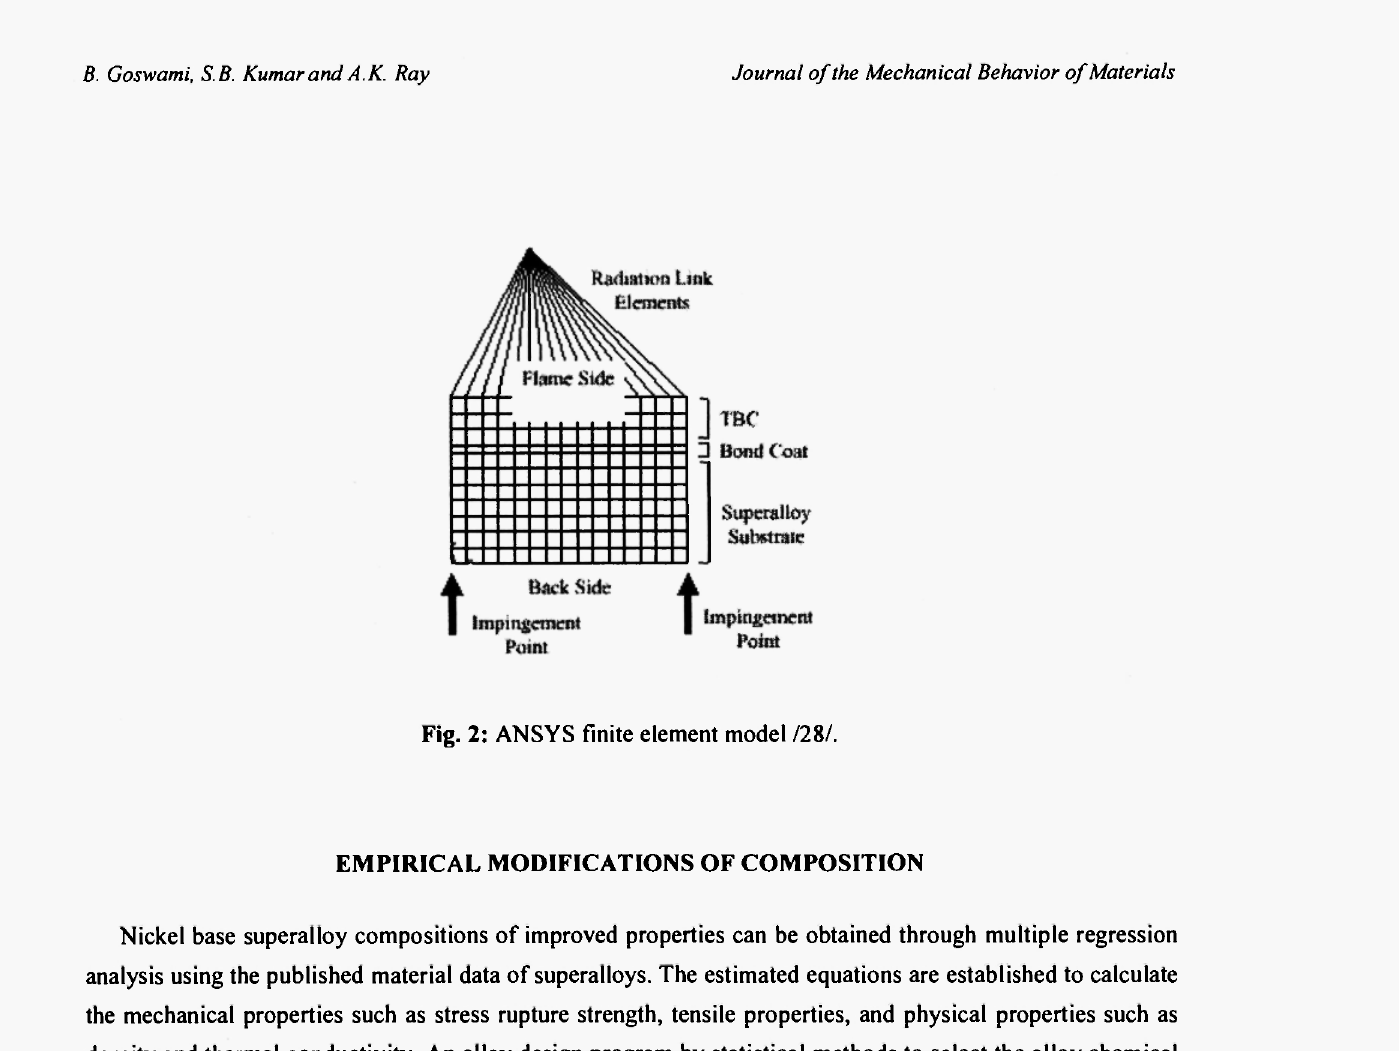
Fig. 2: ANSYS finite element model